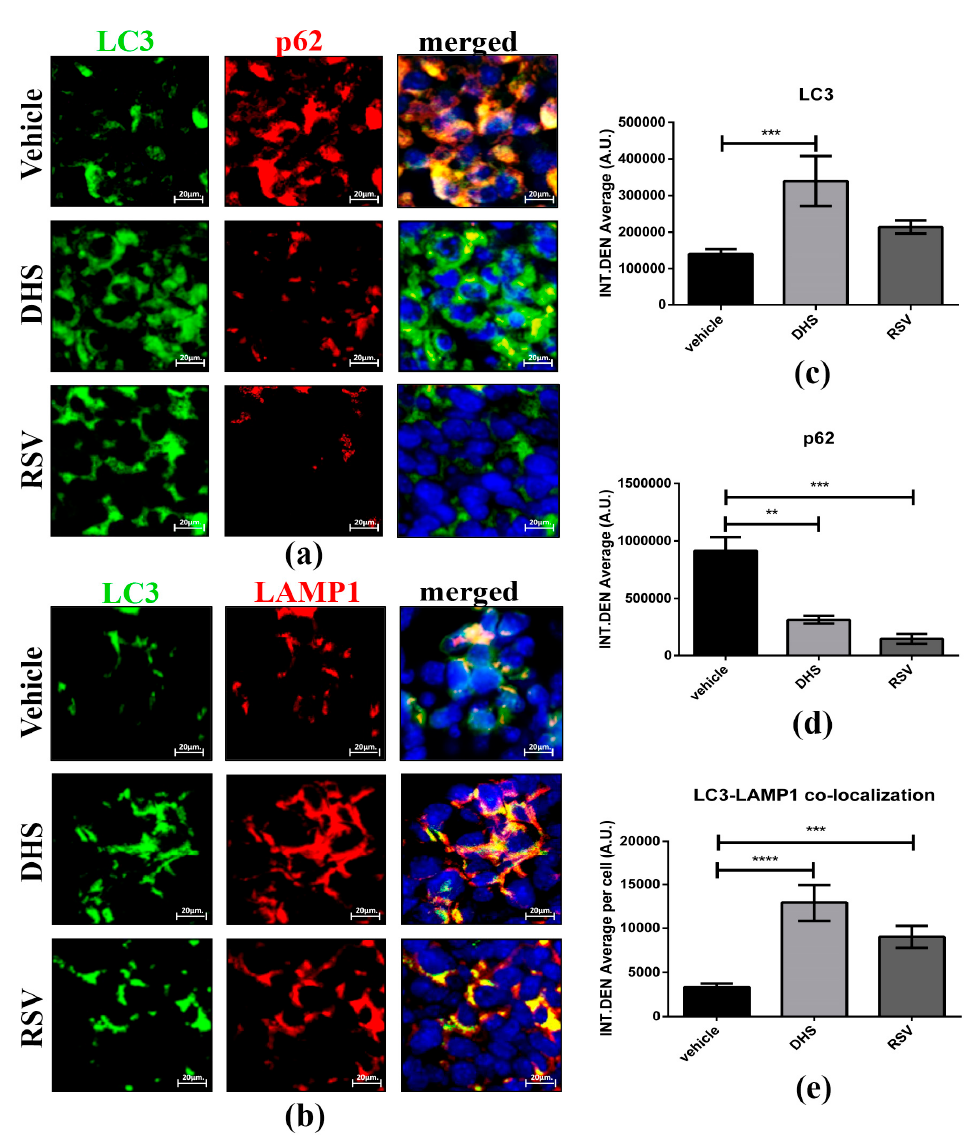
Figure 6. ( a , b) Representative image of LC3 (green)/p62 (red) ( a ) and LC3 (green)/LAMP1 (red) ( b ) co-staining for vehicle, DHS-, and RSV-treated tumour masses (scale bars = 20 μ m; 63× magnification) and relative quantification of LC3 ( c ), p62 ( d ) and LC3-LAMP1 co-localization signal ( e ) in cancer cells (** p < 0.01; *** p < 0.001; **** p < 0.0001).